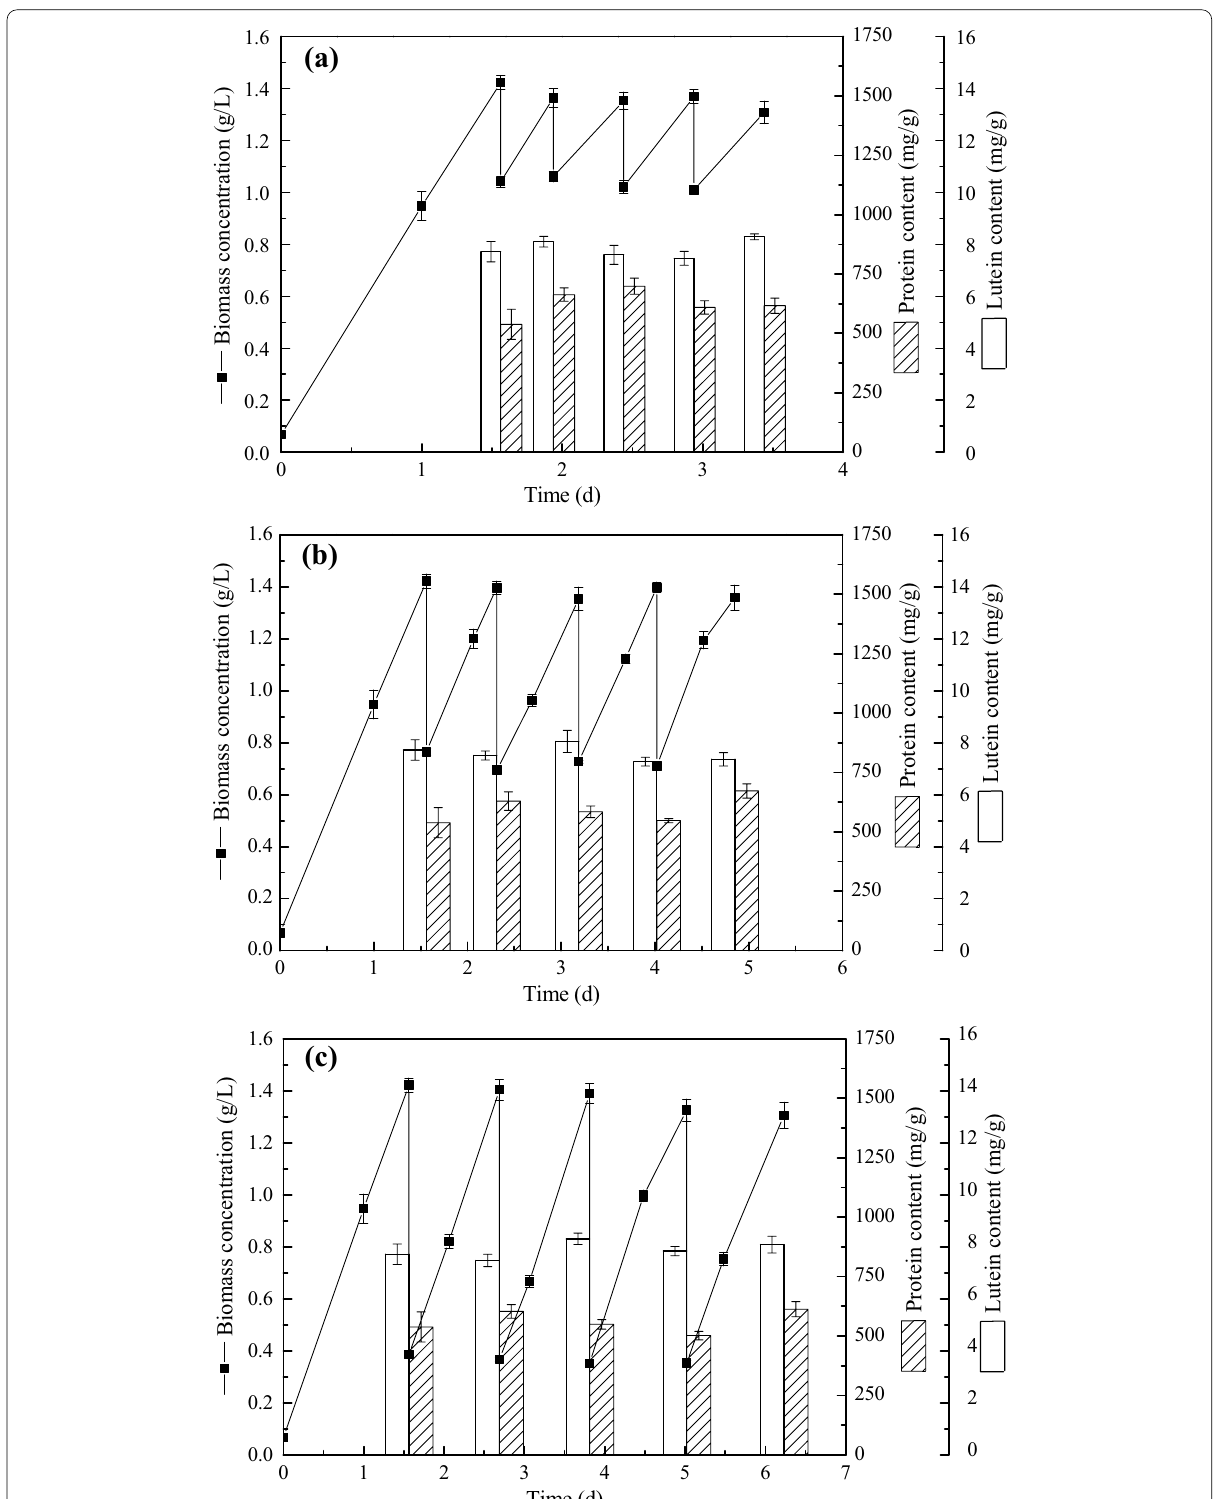
Fig. 2 Cell growth and lutein and protein accumulation of C. sorokiniana FZU60 under semi‑batch cultivation strategies. a Semi‑batch I strategy; b semi‑batch II strategy; c semi‑batch III